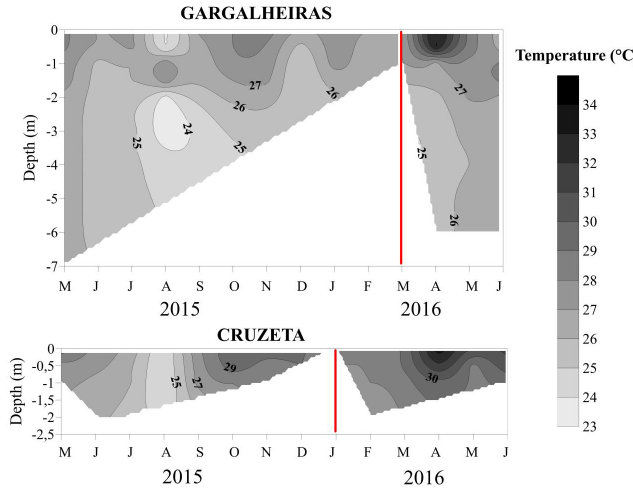
Figure 4. Vertical temperature profiles of Gargalheiras and Cruzeta reservoirs from May 2015 to June 2016. The red line is indicating the highest rainfall in the period, which contributed to the increase in water depth, as can be seen in the figure.